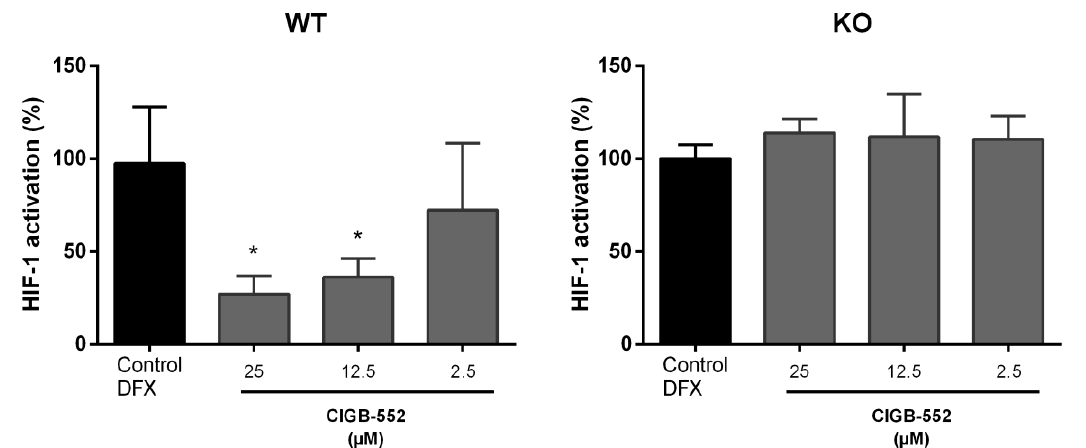
Figure 7. CIGB-552 modulates DFX-induced HIF-1 activation only in H460 WT cells. H460 WT and COMMD1 KO cells were transfected with a pHRE-EPO-luc plasmid and treated with different concentrations of CIGB-552 and 150 μ M DFX for 24 h. Luciferase activity was assessed on cell lysates, normalized by protein content. HIF-1 activation was calculated considering the DFX-stimulated control as 100% activation and data were normalized to this control. Data are represented as the mean ± SD of technical triplicates of one representative experiment out of three. One-way ANOVA analysis (Dunnett’s post -test) was applied to compare the treated groups with the DFX control, * p < 0.05.